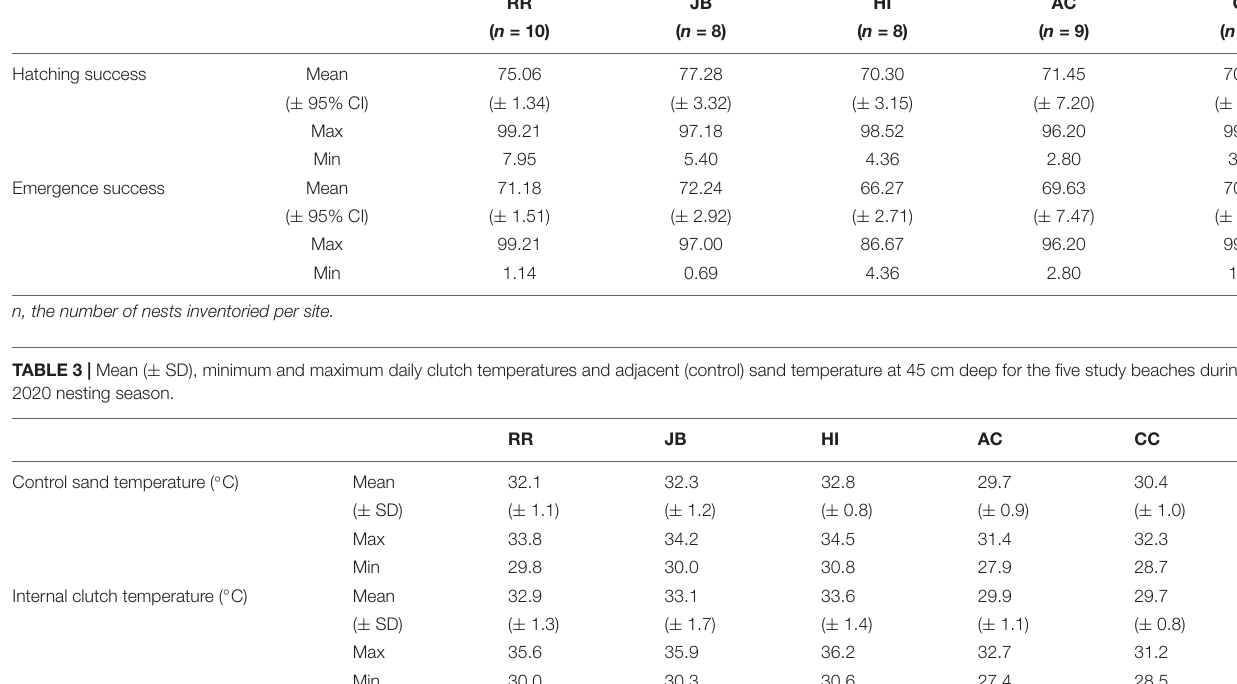
The sites are designated as Red Reef Park, Boca Raton (RR), Juno Beach (JB), Hutchinson Island (HI), Archie Carr National Wildlife Refuge (AC), and Cape Canaveral National Seashore (CC). Note that minimum clutch temperatures usually were warmer than control sand, but maximum sand temperatures were cooler than clutches.